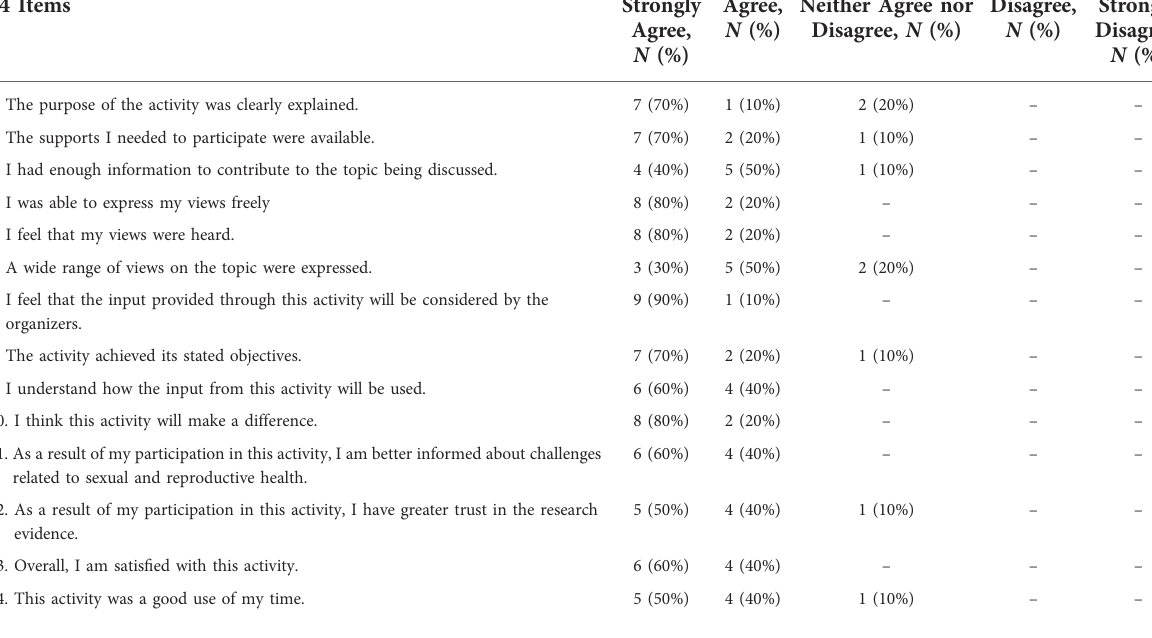
TABLE 2 Results from the 14-item 5-point Likert survey of adolescent advisory group engagement evaluation ( N =10